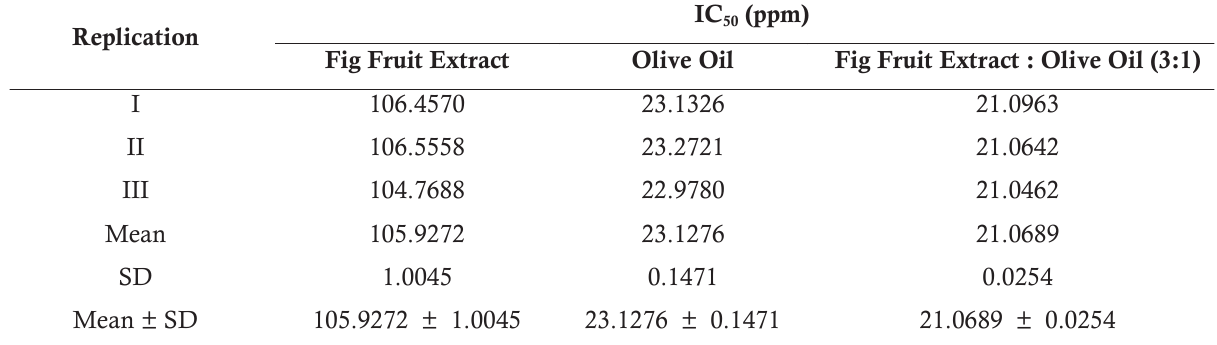
Fig Fruit Extract : Olive Oil